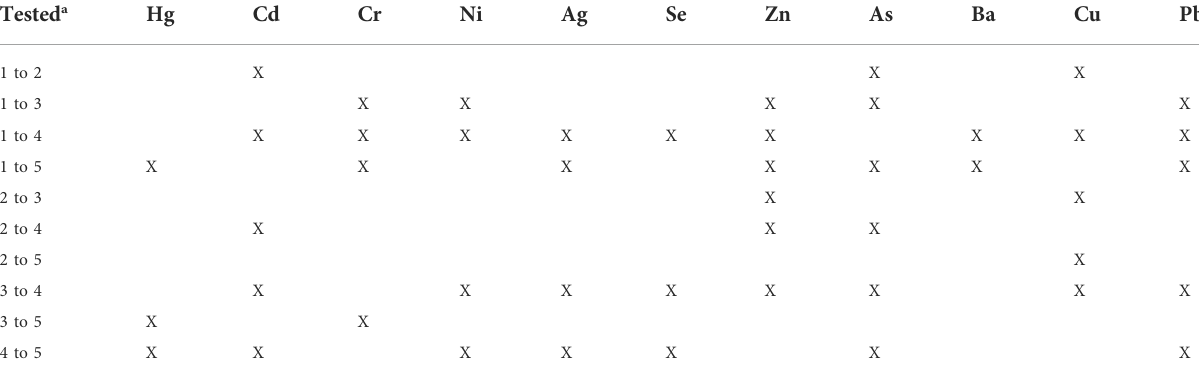
TABLE 4 Student ’ s Two Sample t -Test Results for k-Means Clusters. Tested